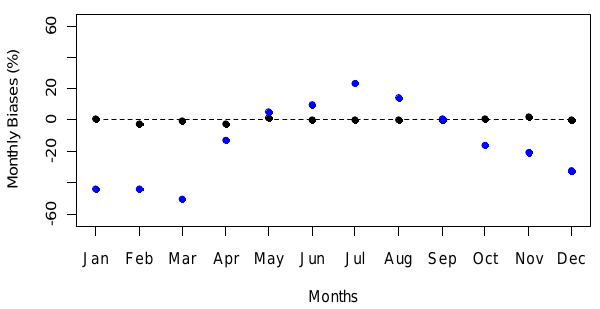
Fig. 7. Monthly biases (%) in Lake EILDON, raw WAPABA predic- Figure 7: Monthly biases % in Lake EILDON, raw WAPABA predictions (blue) and method A 505 tions (blue) and method A (black) [The bias for method A = (mean (black). [The bias for method A = (Mean monthly streamflow observations - Mean probabilistic 506 predictions averaged each month)/ (Average observed monthly streamflow) ; the bias for WAPABA = 507 (mean monthly streamflow observations - mean monthly WAPABA predictions)/ (Average observed 508 monthly streamflow) ]. 509